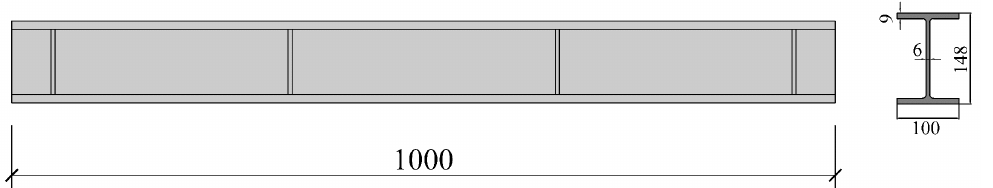
Figure 2. Schematic diagram of test beam size (unit: mm).